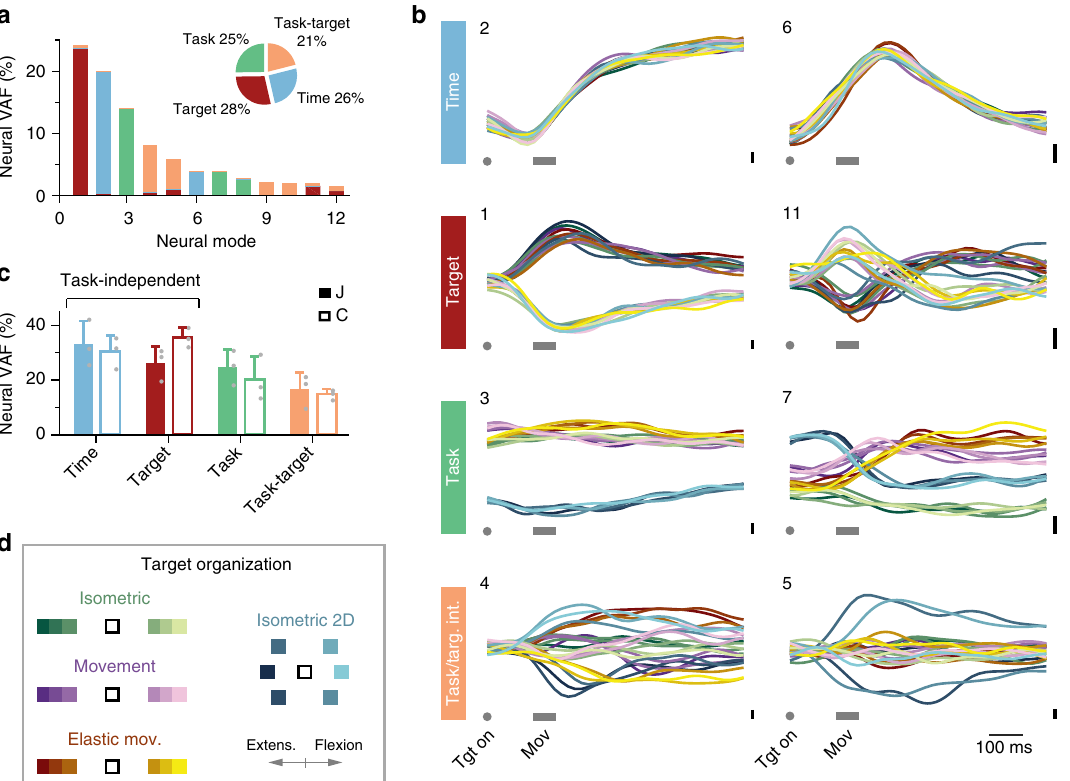
Fig. 4 Task-speci fi c and task-independent activity of dPCA modes. a Neural variance accounted for (VAF) by each neural mode, and its relation to behavioral parameters for one example session from Monkey J. Inset: amount of VAF associated with each behavioral parameter across all 12 modes. b Activity of eight dPCA neural modes, grouped in four sets based on the behavioral parameter they are most strongly associated with. The number on the top left of each panel indicates the ranking of that neural mode in terms of VAF, as in a . Each row corresponds to one behavioral parameter (vertical labels on the left). Each panel has 24 traces, corresponding to each of 24 task/target combinations; color code shown in d . c Total VAF for each behavioral parameter, averaged over sessions for Monkeys J and C. Bars: mean + s.d.; gray circles: individual sessions. d Target locations for each wrist task, color- coded for each task/target combination in b . Tasks are color-coded; extension targets are shown in dark colors and fl exion targets in light results indicate that neural activity synthesized from EMGs is both lower dimensional and less dynamically correlated across tasks than the actual neural activity.